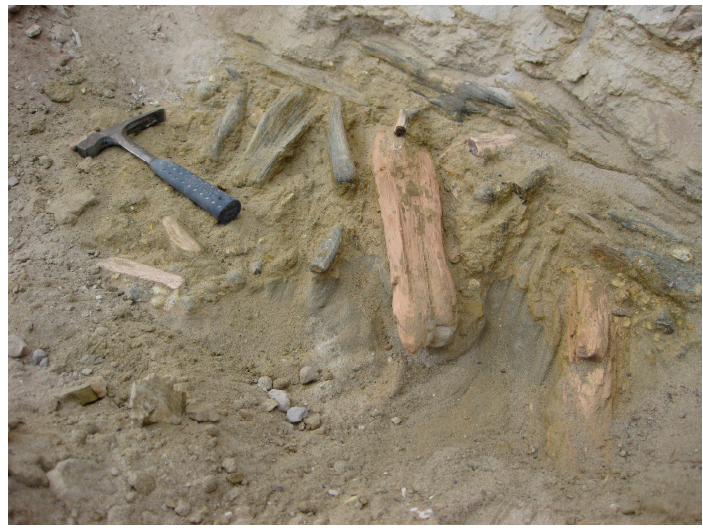
Figure 6. Phosphatized wood at the Bruneau Woodpile site. Elongate limbs and larger wood fragments are positioned in different orientations.